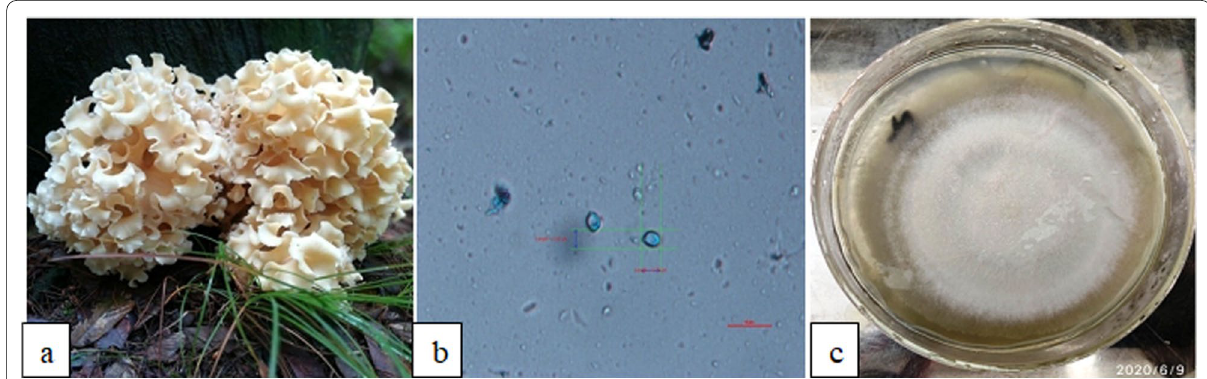
Fig. 1 a Sparassis crispa basidiomes at the base of a conifer. b Spores at 100X magnification. c Mycelial colony of S. crispa after 15 d incubation at 25 °C on PDA